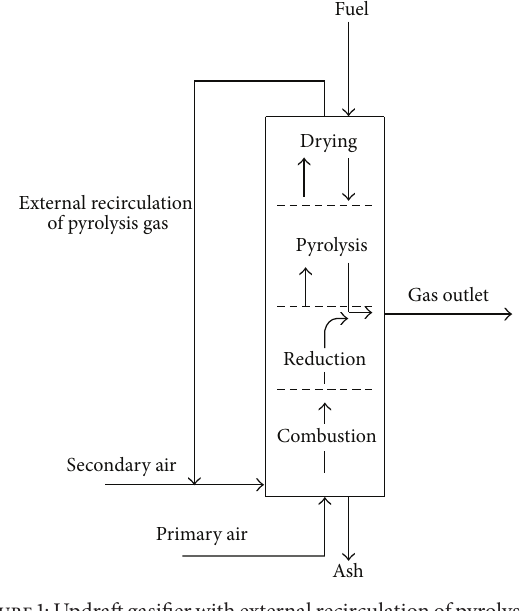
Figure1:Updraftgasifierwithexternalrecirculationofpyrolysisgas